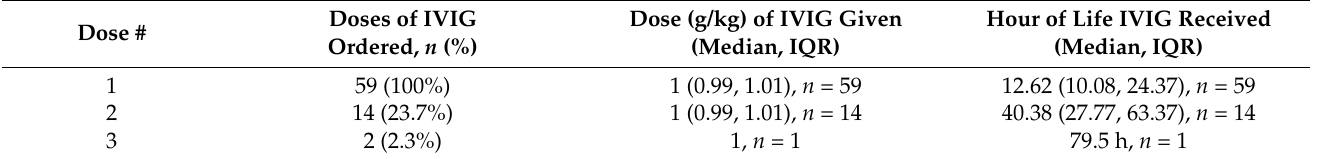
Table 3. Median Dose of IVIG Administered.